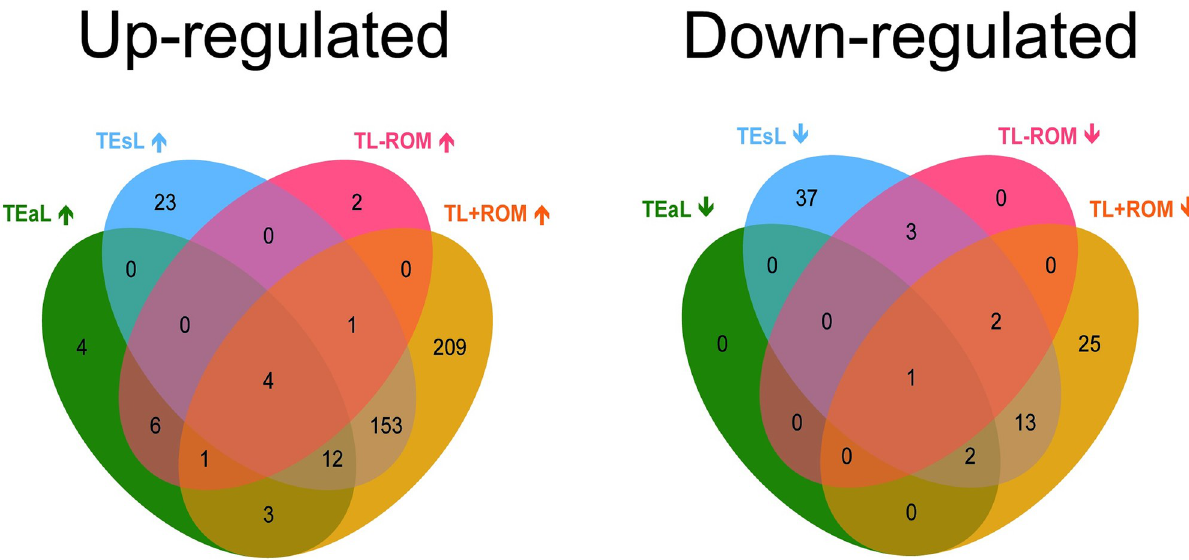
Fig 2. Grouping human myometrium FC � 1.5 DEGs according to cervical dilatation or ROM status at labour. Venn diagrams generated from lists of labour-associated up-regulated ( " ) and down-regulated ( # ) differentially expressed genes (DEGs) in myometrium biopsies, which were obtained from term gestation singleton pregnant women. Values shown only represent number of DEGs that demonstrated median fold change (FC) � 1.5, when compared to the non-labouring state (TNL, n = 8), in transcript abundance for each of type of labour, which was classified by status of cervical dilatation or fetal membrane rupture (ROM; > 1 hour prior to fetal delivery) at time of Caesarean section. For cervical dilatation, labouring women were grouped as either in early ( � 3 cm; TEaL, n = 8) or established ( > 3 cm; TEsL, n = 6) labour. For ROM, women were grouped as either labouring in the absence (TL-ROM, n = 8) or presence (TL+ROM, n = 6) of ROM.